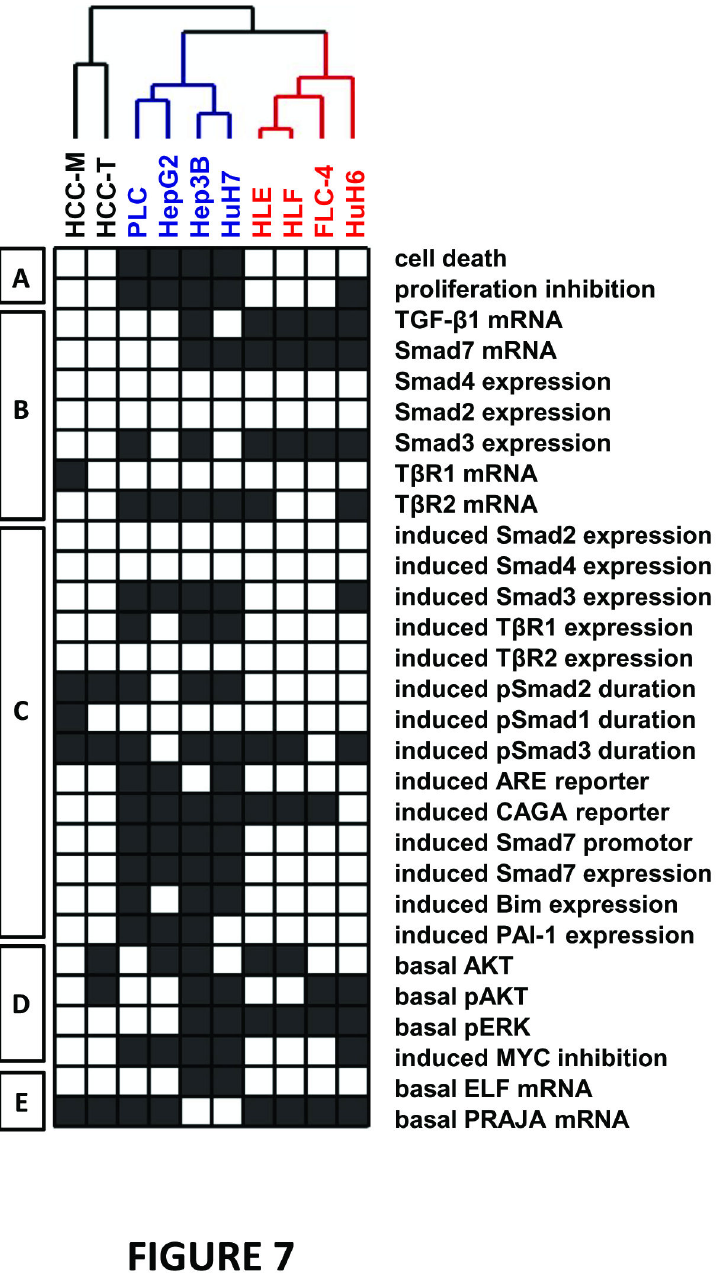
Figure 7. Hierarchical clustering analysis of HCC cell lines based on TGF-β/Smad signaling and cytostatic outcome. TGF- β related observations on the 10 HCC-derived cell lines (as summarized in Figure 9) were converted into an all-or-none fashion (black/white boxes) to produce a matrix which was organized by hierarchical clustering algorithm. Observations were divided into 5 broad categories (A-E, left side). (A) TGF-β dependent cytostasis (black boxes: cell death >5%; proliferation inhibition >50%), (B) basal TGF-β signaling (black boxes: 2 -ΔΔCt > 2.5 for all, but >4 for Smad3), (C) induced TGF-β signaling (black boxes rel. induction of expression 2 -ΔΔCt > 2, induction of CAGA and Smad7 promoter and expression > 2.8, induction of ARE reporter > 5 ; prolonged duration), (D) survival signaling (black boxes: >3-fold increased for pAKT total AKT, 6-fold increased for pERK; > 40% inhibition of c- MYC), (E) basal ELF and PRAJA expression (black boxes: 2 -ΔΔCt >2 and 2 -ΔΔCt >1.4 respectively). Based on the integrated above observations, clustering analysis unambiguously clustered the 10 cell lines. Beside HCC-M and HCC-T cell lines, 2 main groups were identified: group 1 included HepG2, PLC, Hep3B, HuH7 and group 2 included HLE, HLF, HuH6, FLC-4. doi: 10.1371/journal.pone.0072252.g007 PLOS ONE |